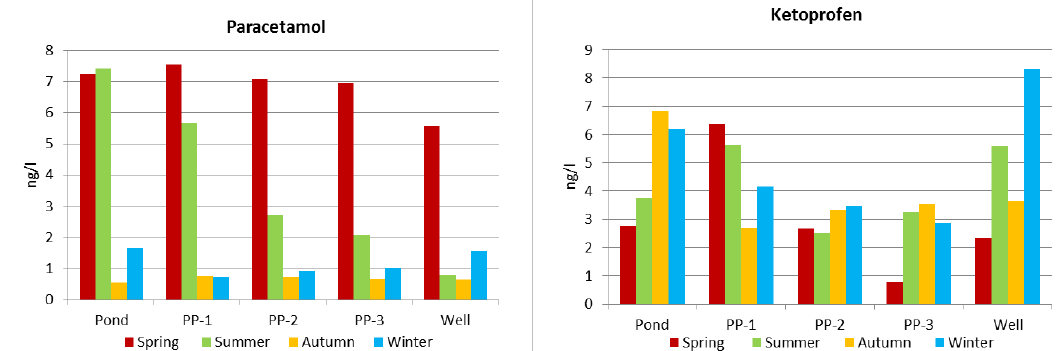
Energies 2021 , 14 , x FOR PEER REVIEW Figure 4. Concentrations of paracetamol and ketoprofen throughout the infiltration route in subsequent measurement series.